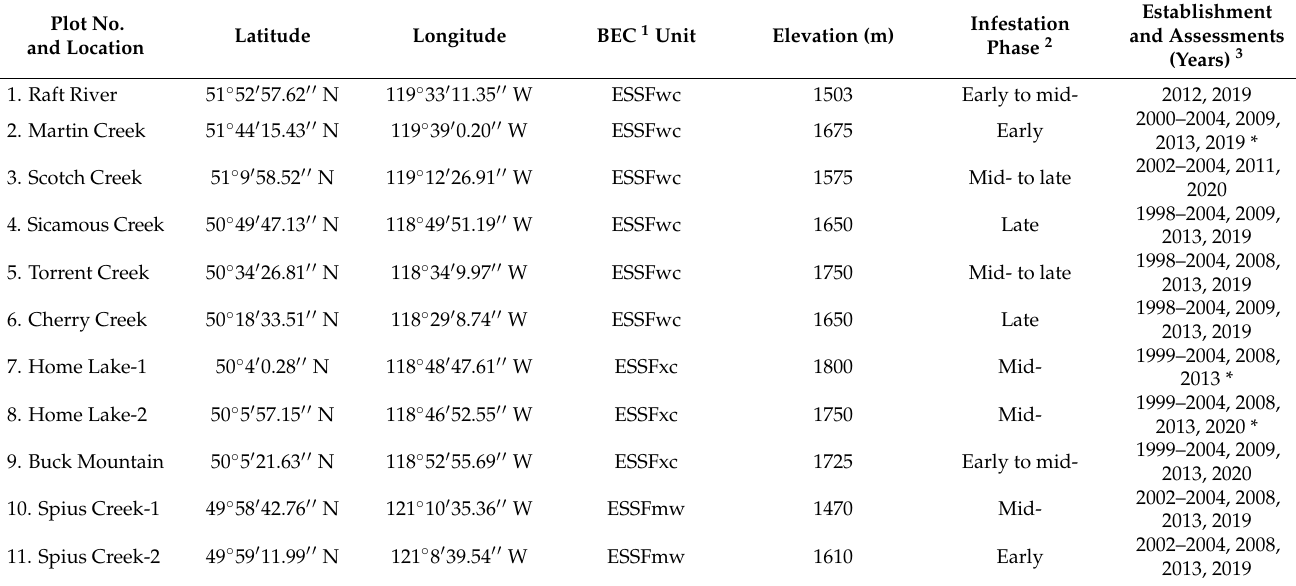
Table 1. Geographic location, latitude, longitude, biogeoclimatic classification, elevation (meters), D. confusus infestation phase, year of establishment, and years of assessment for 11 one-hectare plots in southern interior British Columbia.